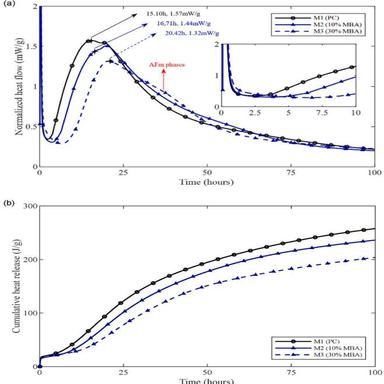
Heat evolution as a function of time in mixtures with MBA at different